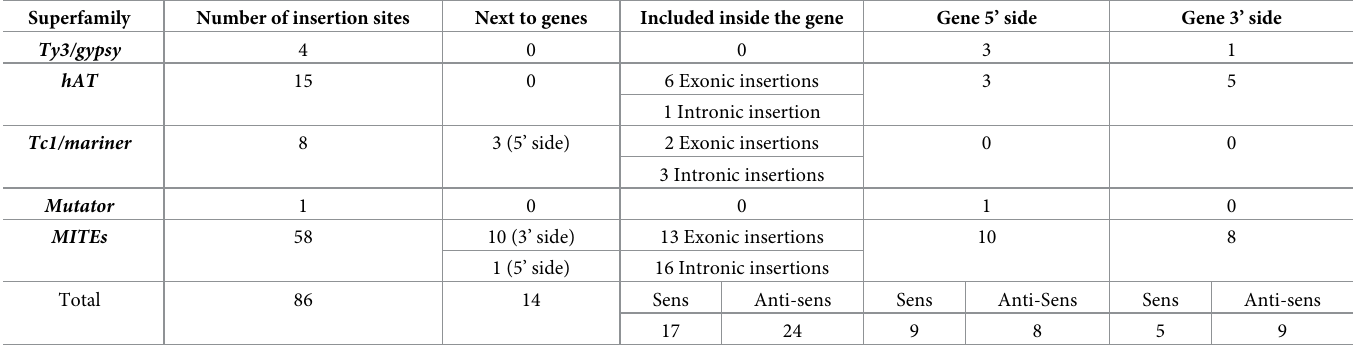
Table 3. Categories of insertion sites and numbers of TEs having recently transposed (less than 2% of divergence).